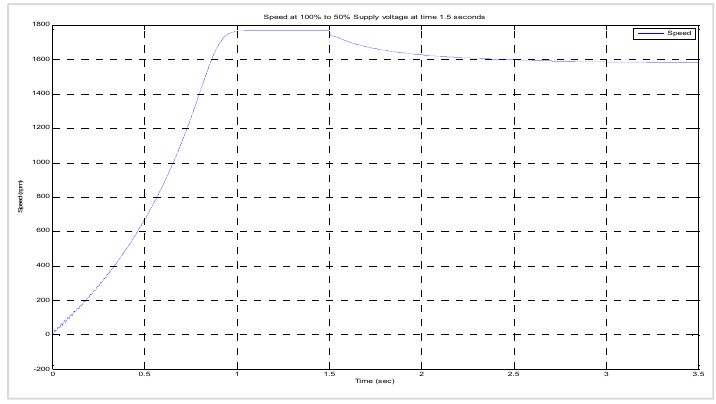
Figure 27. The speed when the supply voltage changes from 100% to 50% at 1.5 s.